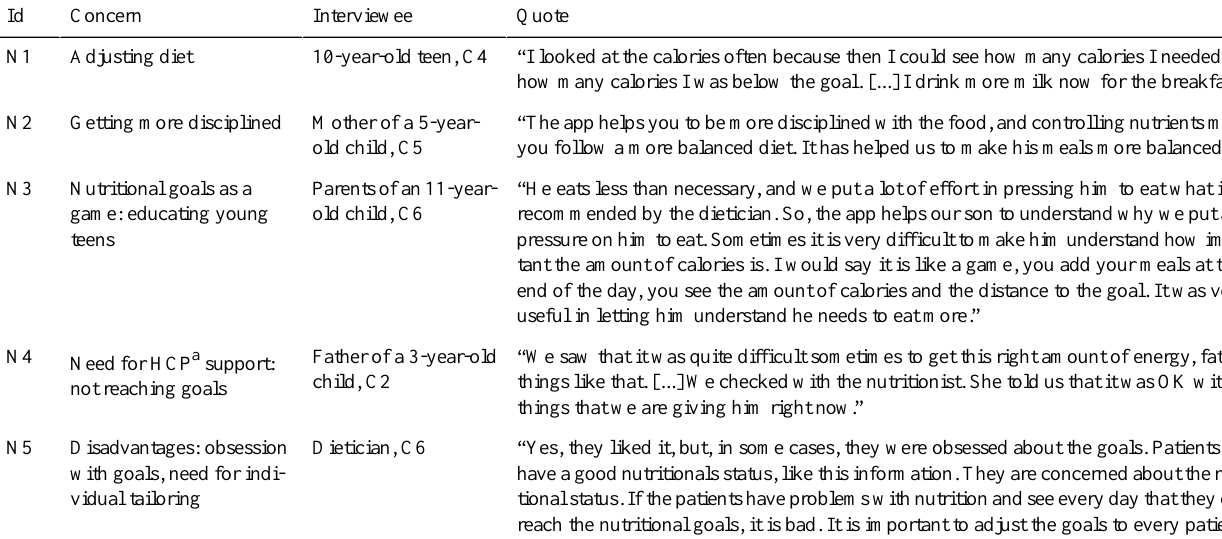
Table 5. Illustrative quotes related to using the self-management app: nutrition management.